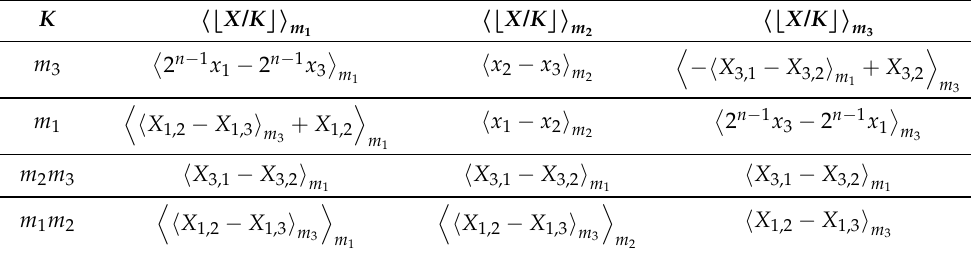
Table 1. Calculation methods for four different scaling